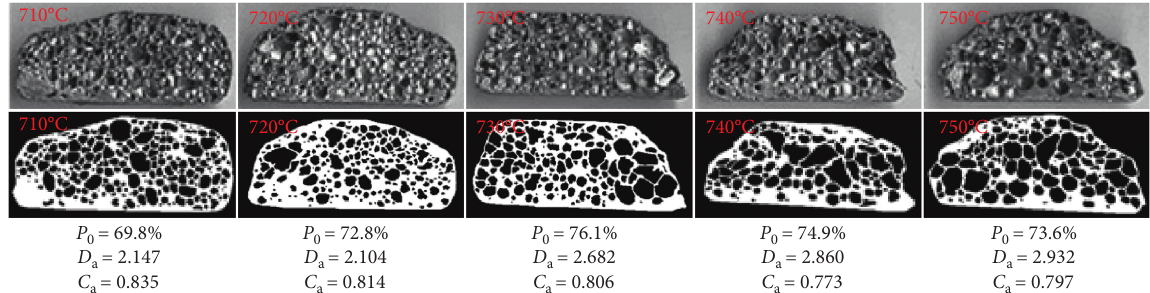
Figure 6: Cross-sectional macrographs of foams in tube A on the five sample temperatures at furnace temperature 760 ° C.